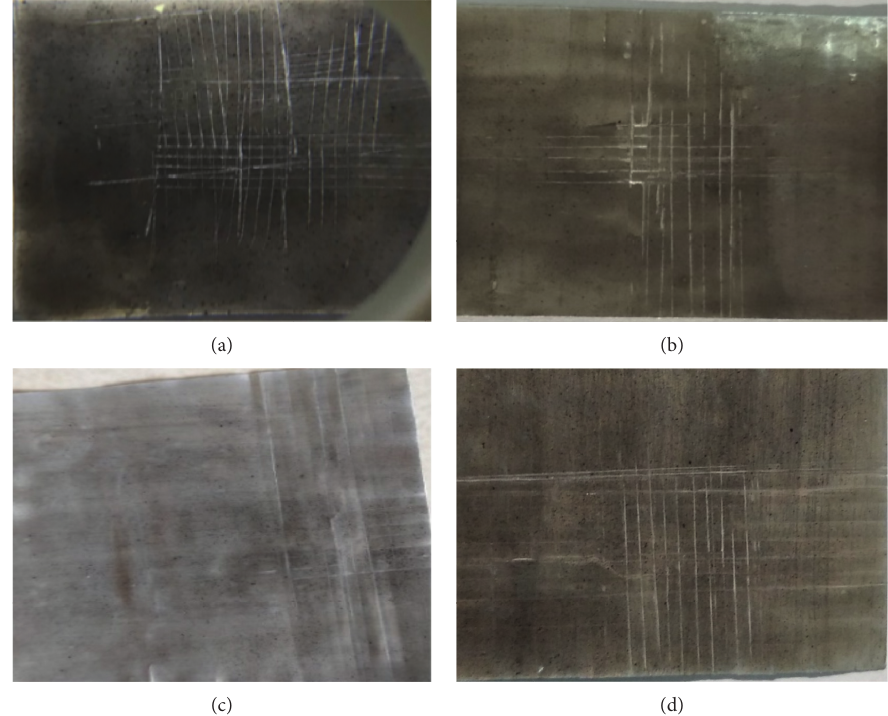
Figure 1: Sample after adhesion measurement (FA: Fly ash) (a) F1 (0.5 wt.% MWCNTs, 10 wt.% FA), (b) F2 (1 wt.% MWCNTs, 10 wt.% FA),